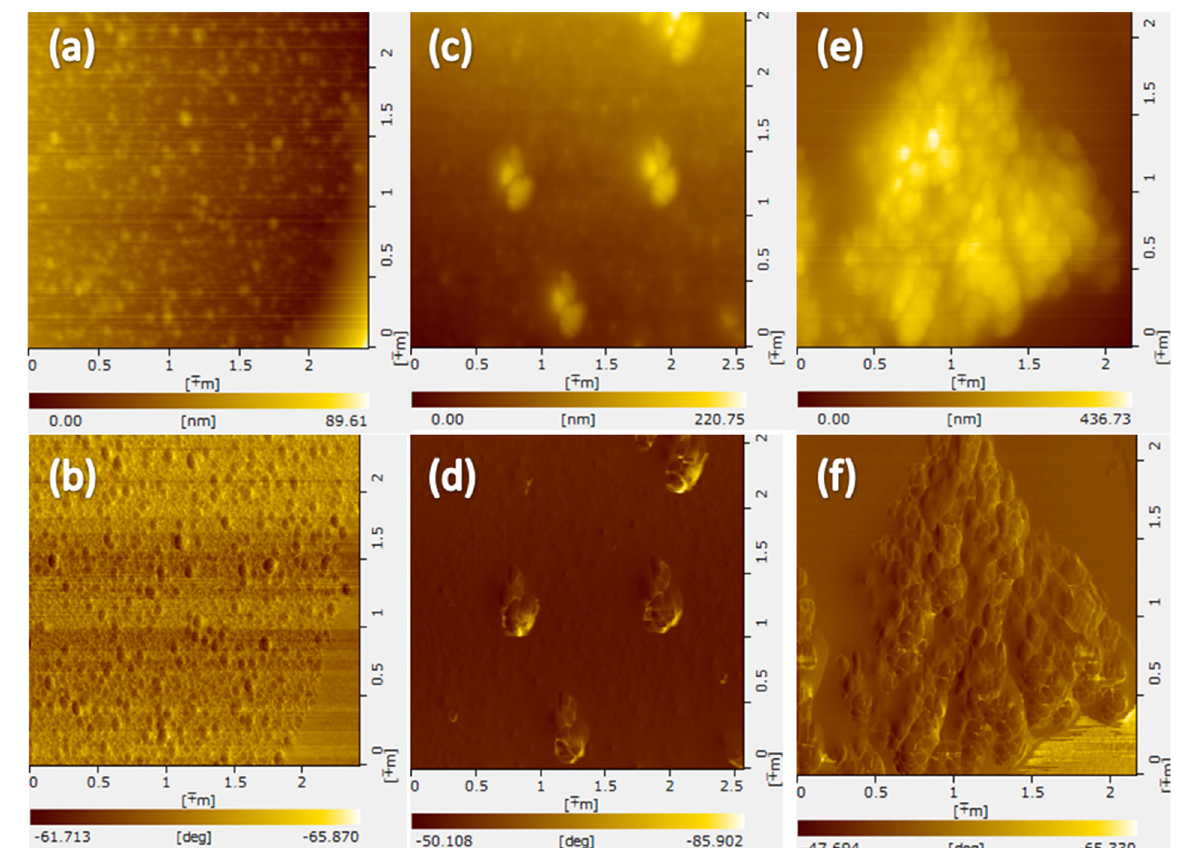
Figure 5. AFM images of the trypsin-EGCG complex at different EGCG concentrations with phase image ( b , d , f ) and 2D topographic profile ( a , c , e ); ( a , b ) pure trypsin (8.4 µ M); ( c , d ) the trypsin-EGCG complex (trypsin 8.4 µ M, EGCG 30 µ M); ( e , f ) the trypsin-EGCG complex (trypsin 8.4 μ M, EGCG 60 μ M).